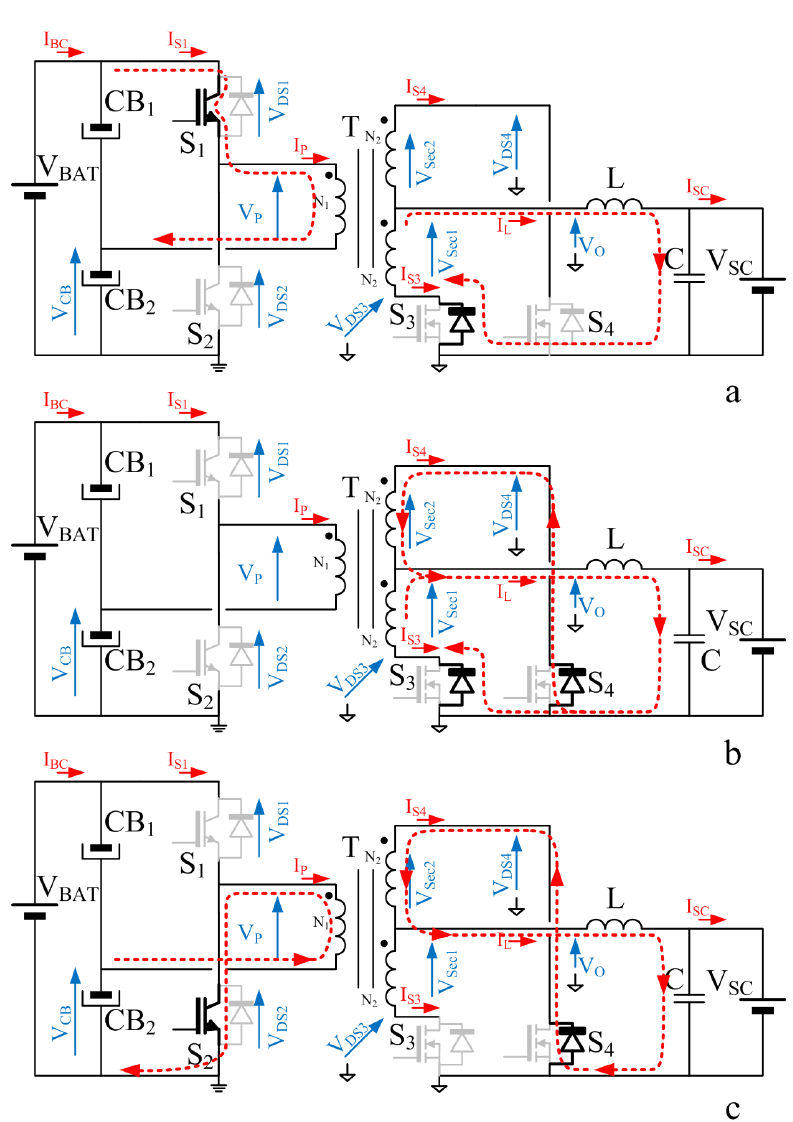
Figure 4. Switching modes of the half-bridge current-source (HBCS) converter operating during supercapacitor (SC) charging operation mode. ( a ) Switch S 1 on and switch S 2 off. ( b ) Both switches S 1 and S 2 off. ( c ) Switch S 1 off and switch S 2